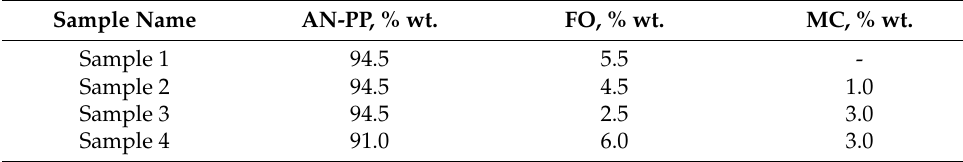
Table 1. Non-ideal explosive compositions, %